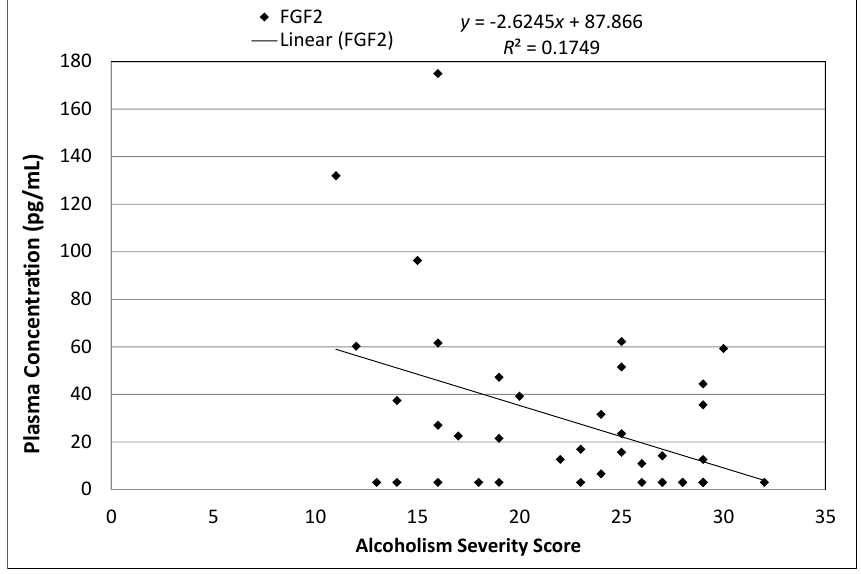
Figure 2. A scatter plot shows the relationship between plasma FGF2 concentration and Alcoholism Severity Score for n = 40 adult male African-American participants with chronic severe alcoholism. A trend line indicates the strength of the linear correlation. Hematopoietic Cytokine FGF2 Inversely Correlated with Alcoholism Severity in Men.